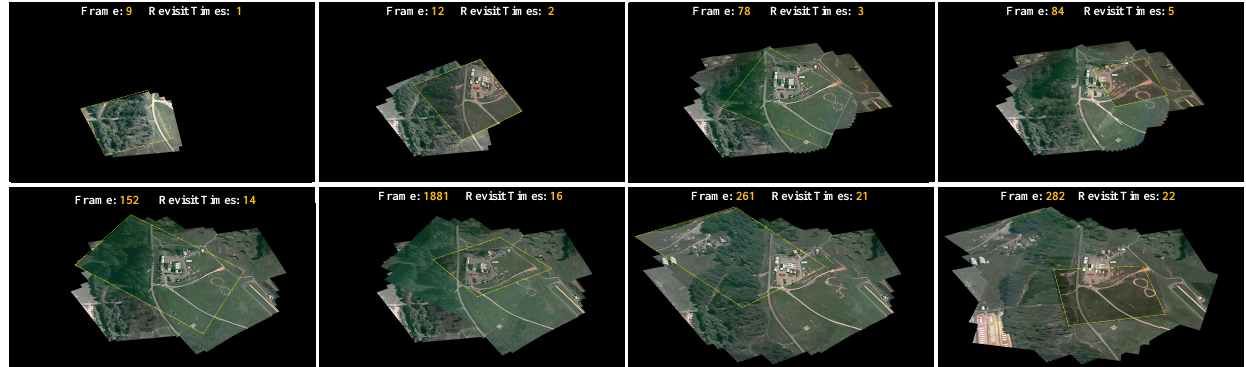
Figure 8. Example of dynamic stitching process of a surveillance scene with 22 revisits from 2312 VIRAT images; the yellow dotted line shows the first image from a new